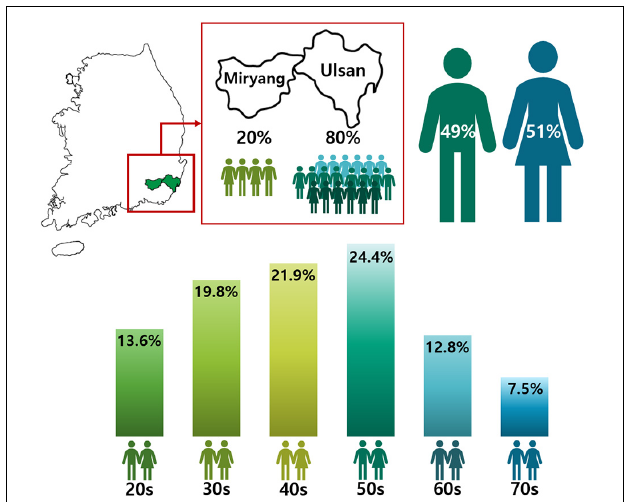
FIGURE 1 | Gender and Age distribution in the Welfare Genome Project. The map shows regions sampled in South Korea. 80% of the participants were from Ulsan, while the remaining 20% were from Miryang. The numbers in the figure show the distribution by gender and age in the Welfare Genome